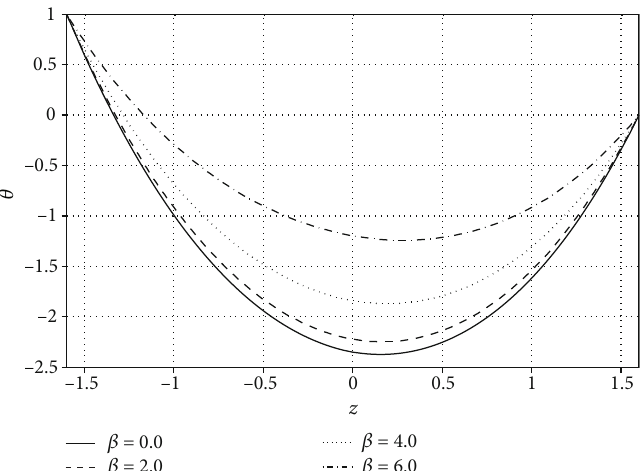
Figure 14: Temperature pro fi le for di ff erent values of β for fi xed values of φ = 0 : 6 , x = 0 We = 0 : 03 , n = 2 , Q = − 1 , y = 1 , Pr = 0 : 5 , and Ec = 0 : 2 .